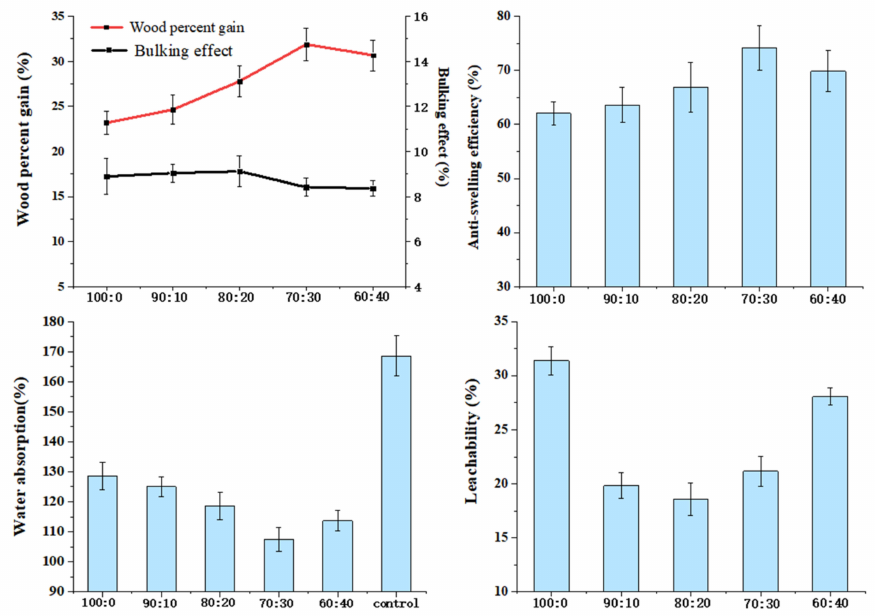
Figure 6. Effects of the ratio of HEMA and glyoxal on properties of